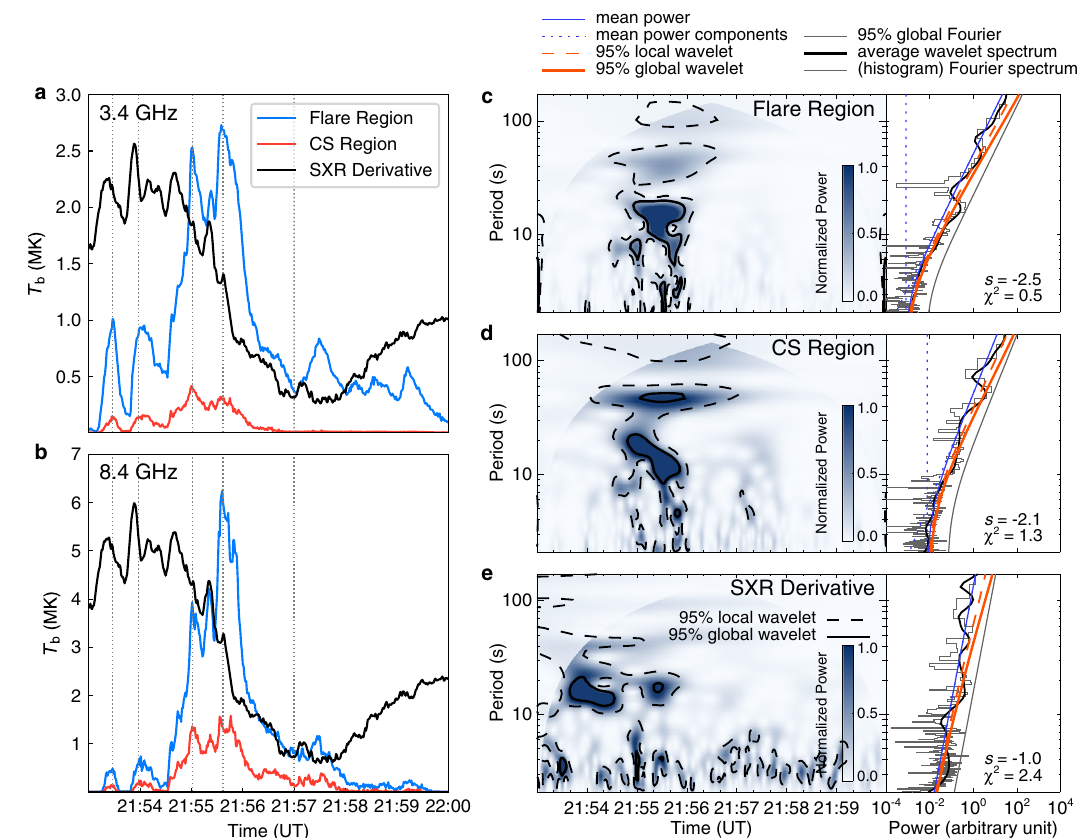
Fig. 3 | Temporal variations and periodicity of brightness temperature and time derivative of SXR fl ux. a The variations of brightness temperature, T b , the maximalvalueswithincorrespondingboxesasinFig.4c,ofthemicrowavesources atthe fl areloops(blue,RegionC)andtheentireCSregion(red,includingRegion0, 1, and 2) at the frequency of 3.4GHz. The black curves represent the 11-second- smoothed time derivative of the GOES SXR 1 – 8Å emission. The vertical dot lines mark the fi ve instants when the resolved microwave and EUV images are shown in Fig.2. b The sameas( a ) but at 8.4GHz. c The normalizedwavelet power spectrum of T b variation of the fl are loops region at 8.4 GHz and time-averaged Fourier/ wavelet spectrum. The region with shallower color denotes the cone of in fl uence (COI),underwhichtheperiodsareinsigni fi cant.Theblackdottedcontoursenclose